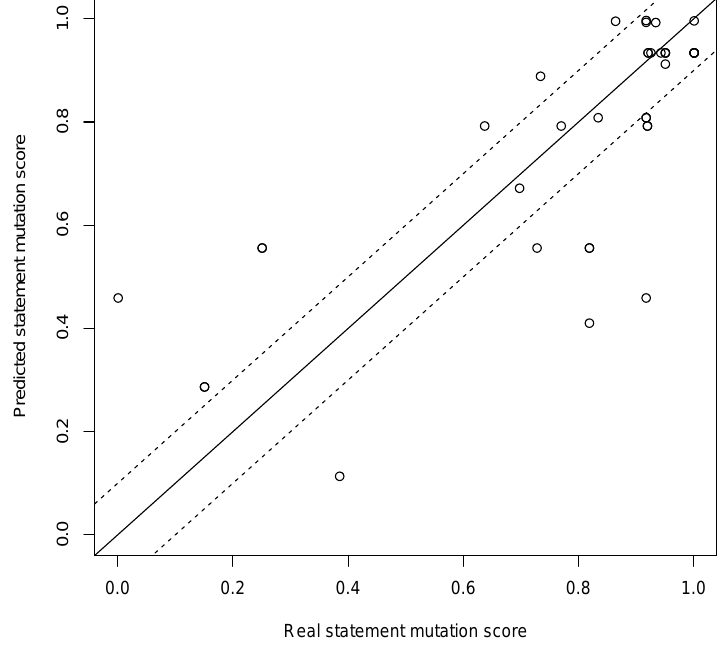
Figure 10. Comparing the real statement mutation scores and the predicted statement mutation scores in schedule.c by the artificial neural